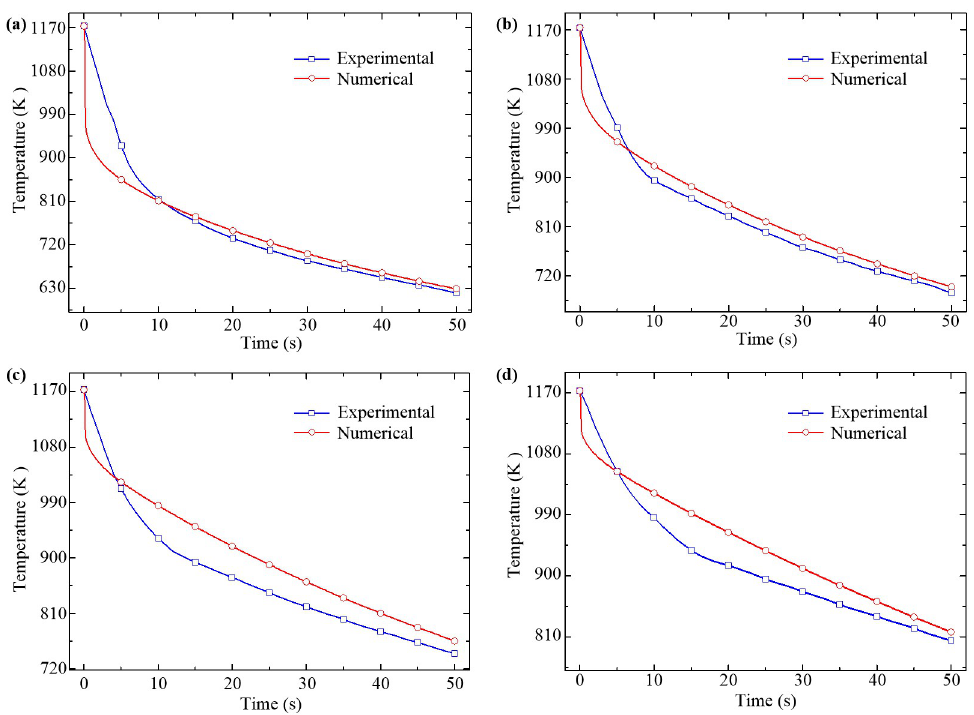
Fig 8. Comparisons of numerical and experimental temperatures at different radial positions. (a) y = 0 mm, (b) y = 20 mm, (c) y = 40 mm, (d) y = 60 mm.